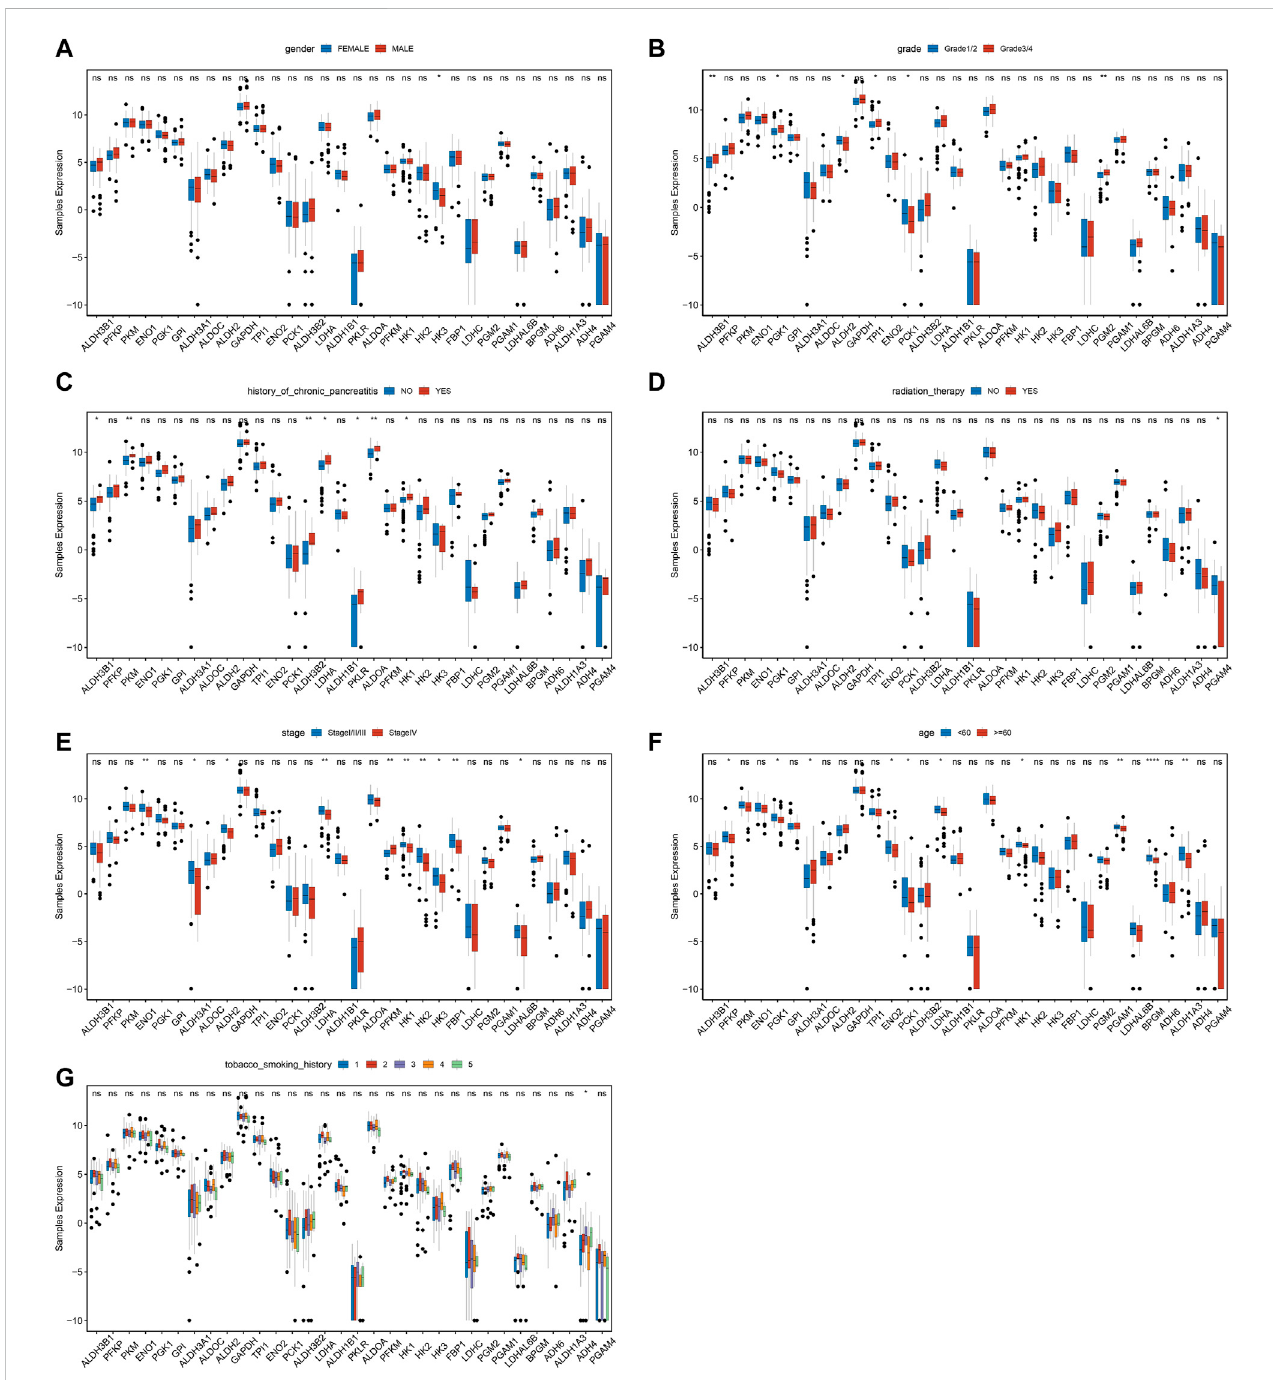
FIGURE 2 Expression difference of MMRG coregene of clinical characteristics in tumor and normal samples. (A – G) The expression difference of MMRG core gene set of gender, grade, history of chronic pancreatitis, radiotherapy, stage, age, and smoking history, respectively.